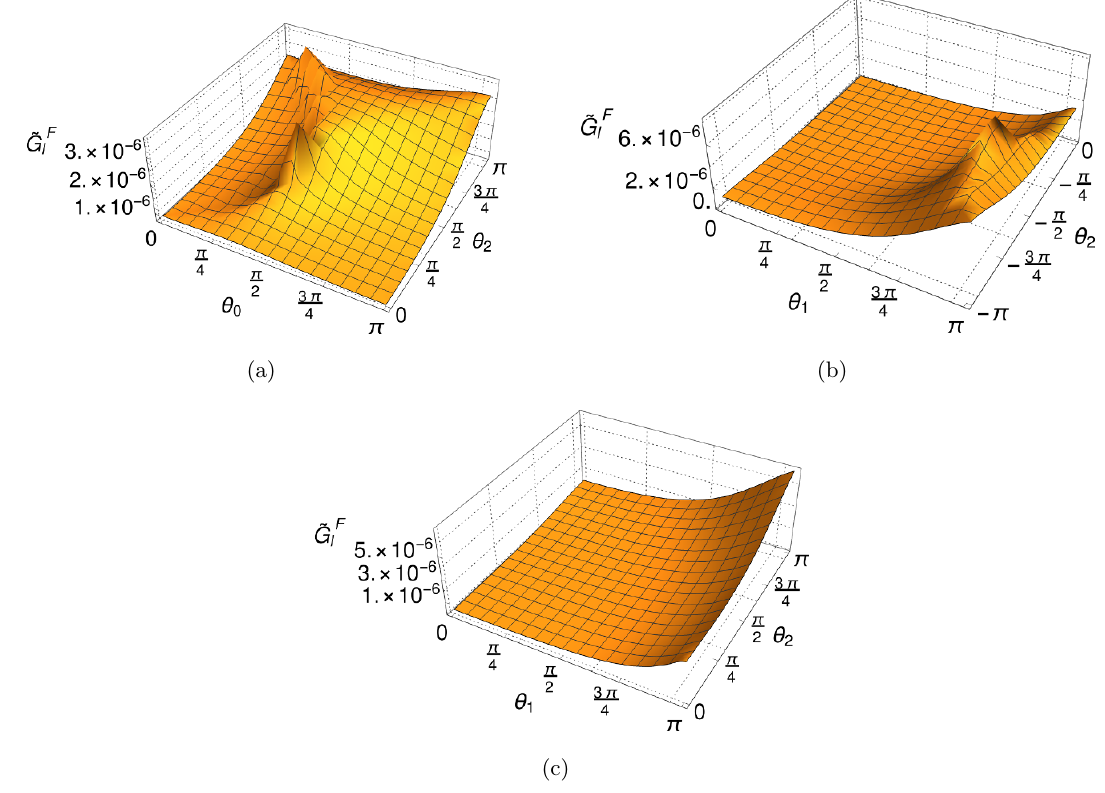
Figure 7 . The I10 2 integrand at O ( (cid:15) 0 ) is shown after a complex mapping and exact integration of one variable in three di(cid:11)erent con(cid:12)gurations. In (a), the contour orientation is chosen by the algorithm but an arbitrary choice of integration variable is allowed. In (b), the exact integration variable is chosen by the algorithm but an arbitrary choice of contour is allowed. In (c), the contour and exact integration variable are chosen by TayInt . The kinematic scales are set to u = 5 : 44 m 2 m 2 = m 1 p and m 1 = 173 2